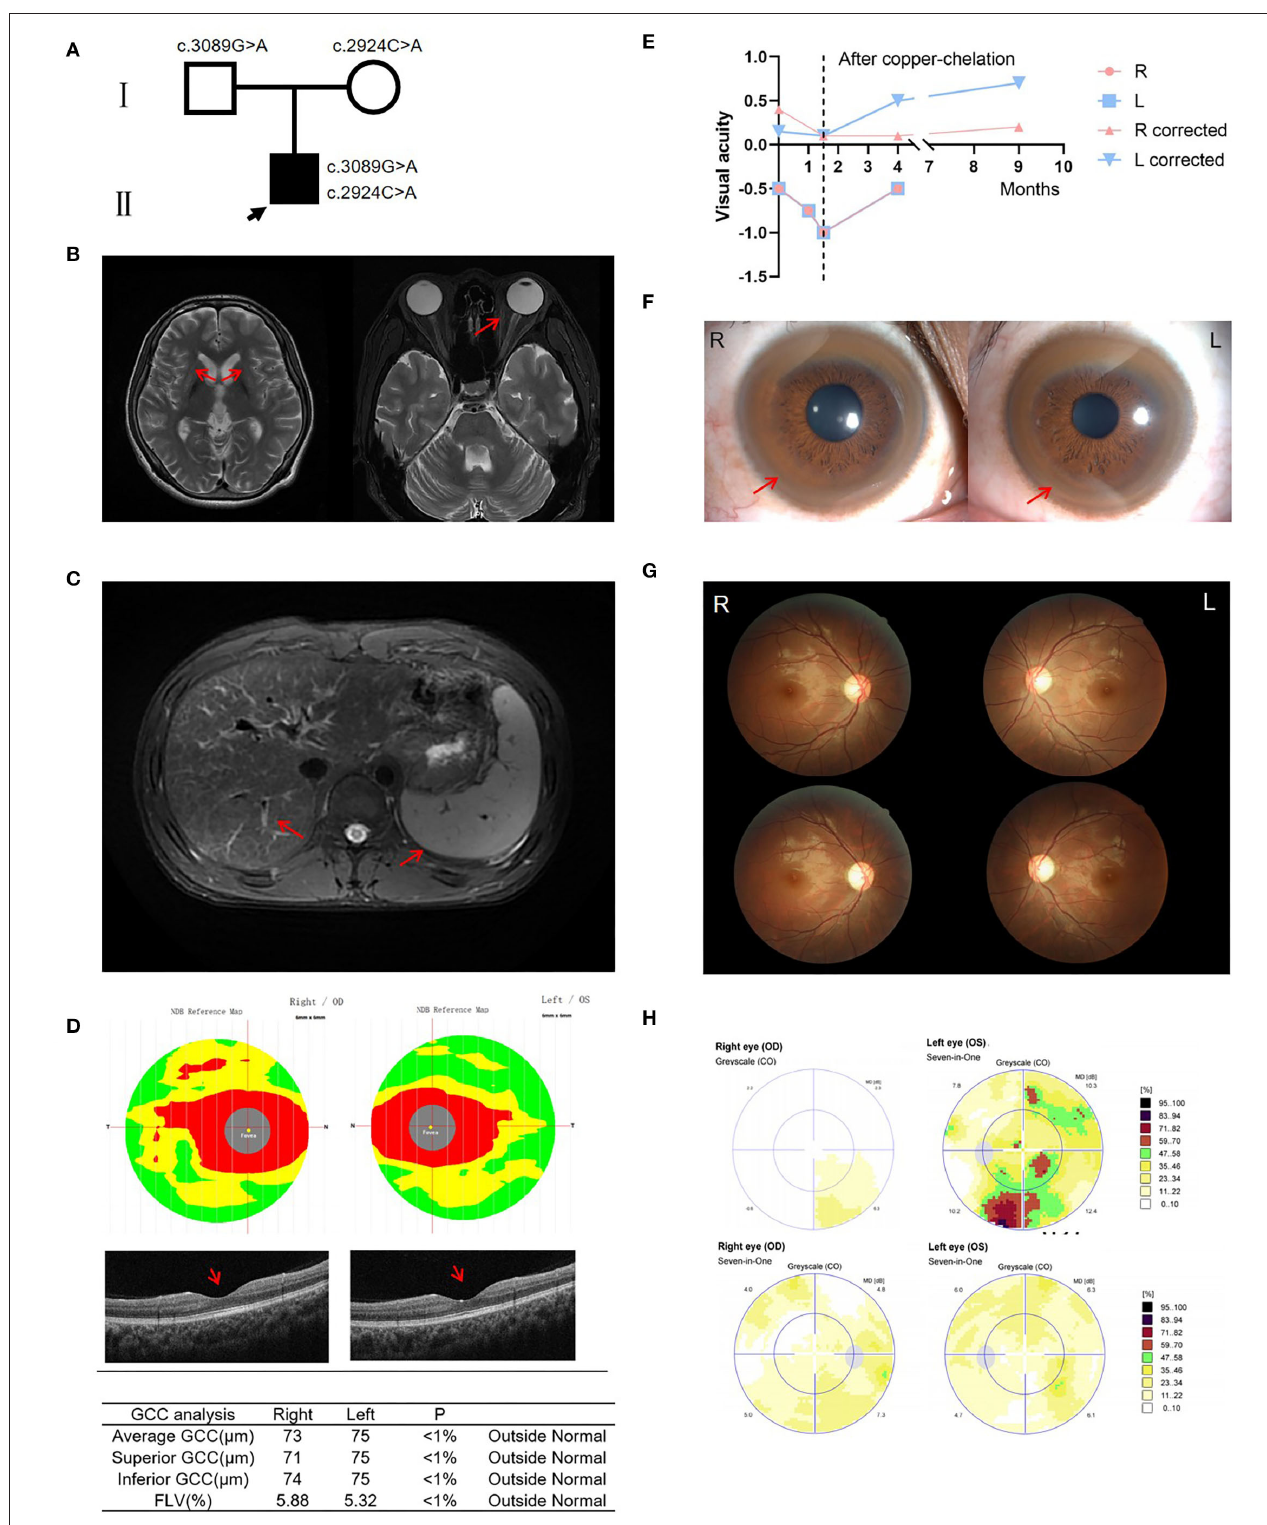
FIGURE 1 | Clinical information of the patient. (A) Pedigree of the family. (B) Brain MRI showed symmetric hyperintense changes visualized in T2-weighted images of the basal ganglia, particularly the putamen; Orbit MRI showed no evidence of signal abnormality involving optic nerve or external compressive mass